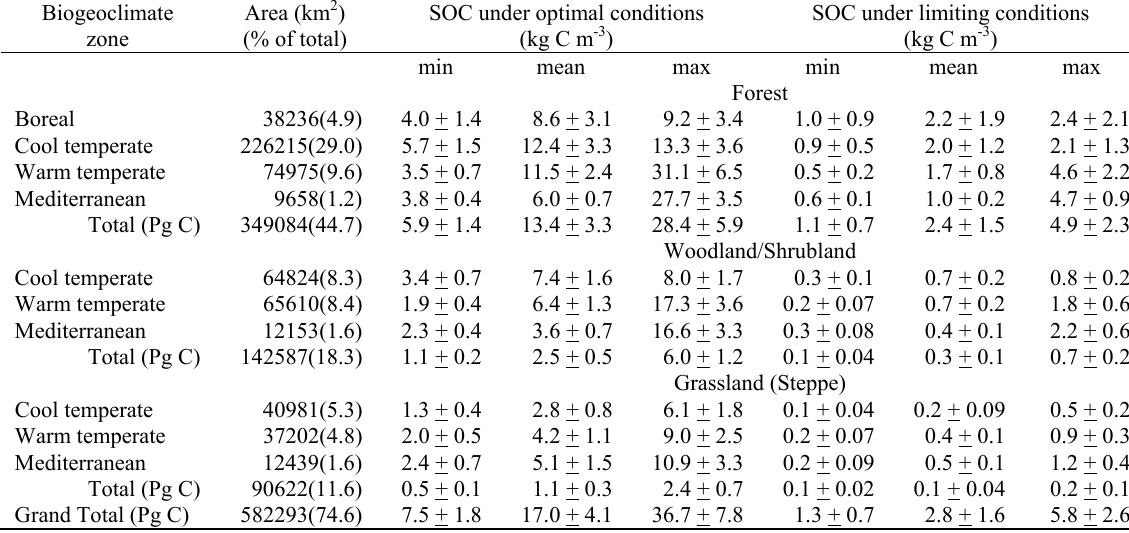
Values given as mean + standard deviation may not total due to